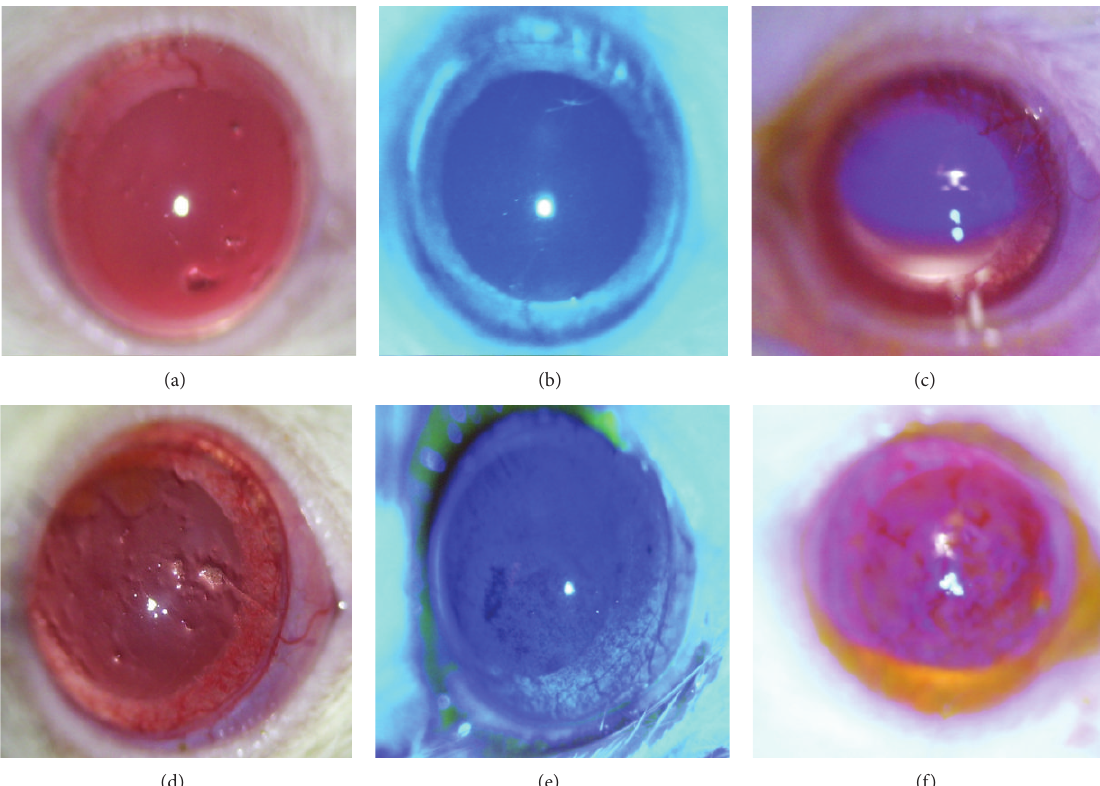
Figure 2: Representative biomicroscopic fluorescein and Rose Bengal staining photographs of groups. MSC-treated group ((a), (b), and (c), resp.) and PBS-treated group ((d), (e), and (f), resp.). Punctate epitheliopathy was observed in PBS-treated rats and there were increased Rose Bengal and corneal fluorescein score grades in PBS-treated